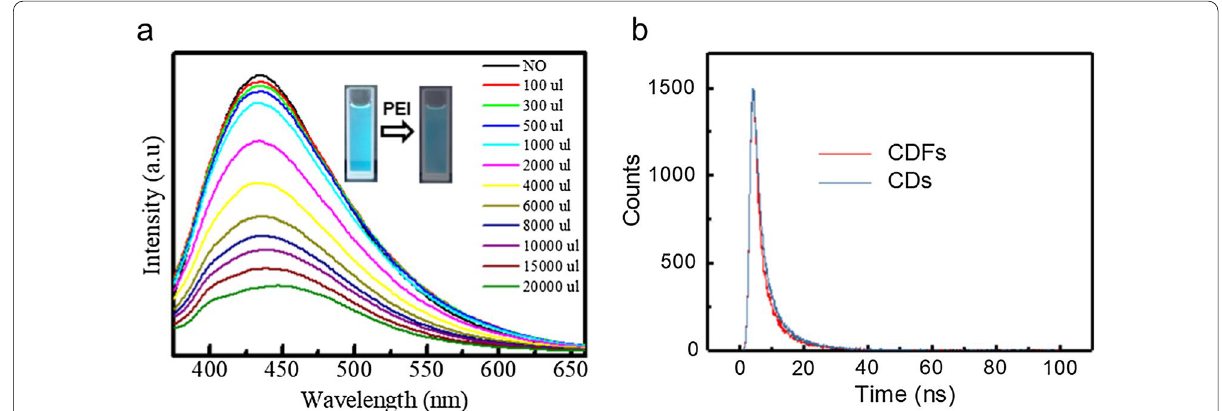
Fig. 4 Fluorescence emission spectra a of CDs as the titration of PEI, and lifetime b for CDs and CDFs